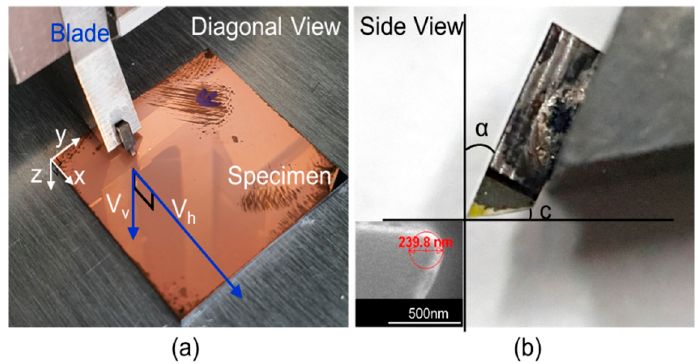
Figure 2. Nano cutting test and blade: ( a ) cutting system with specimen; ( b ) diamond blade and SEM image of the blade edge (lower left).